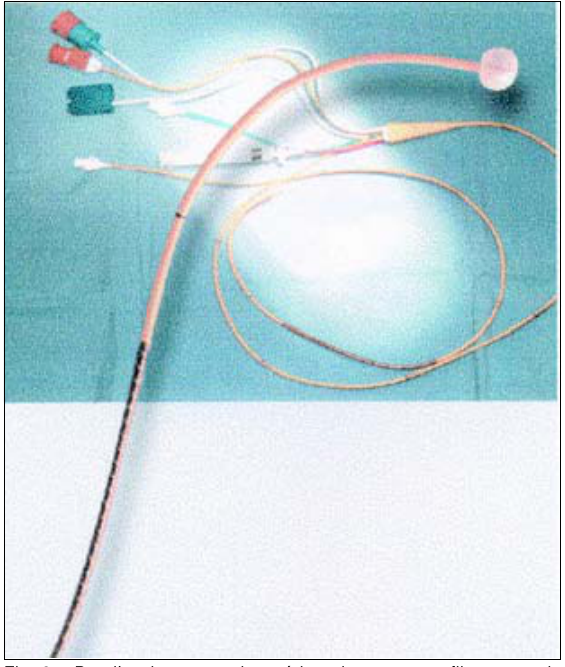
Fig. 2 (cid:150) Detalhe do cateter da artØria pulmonar, com filamentos de aquecimento distal